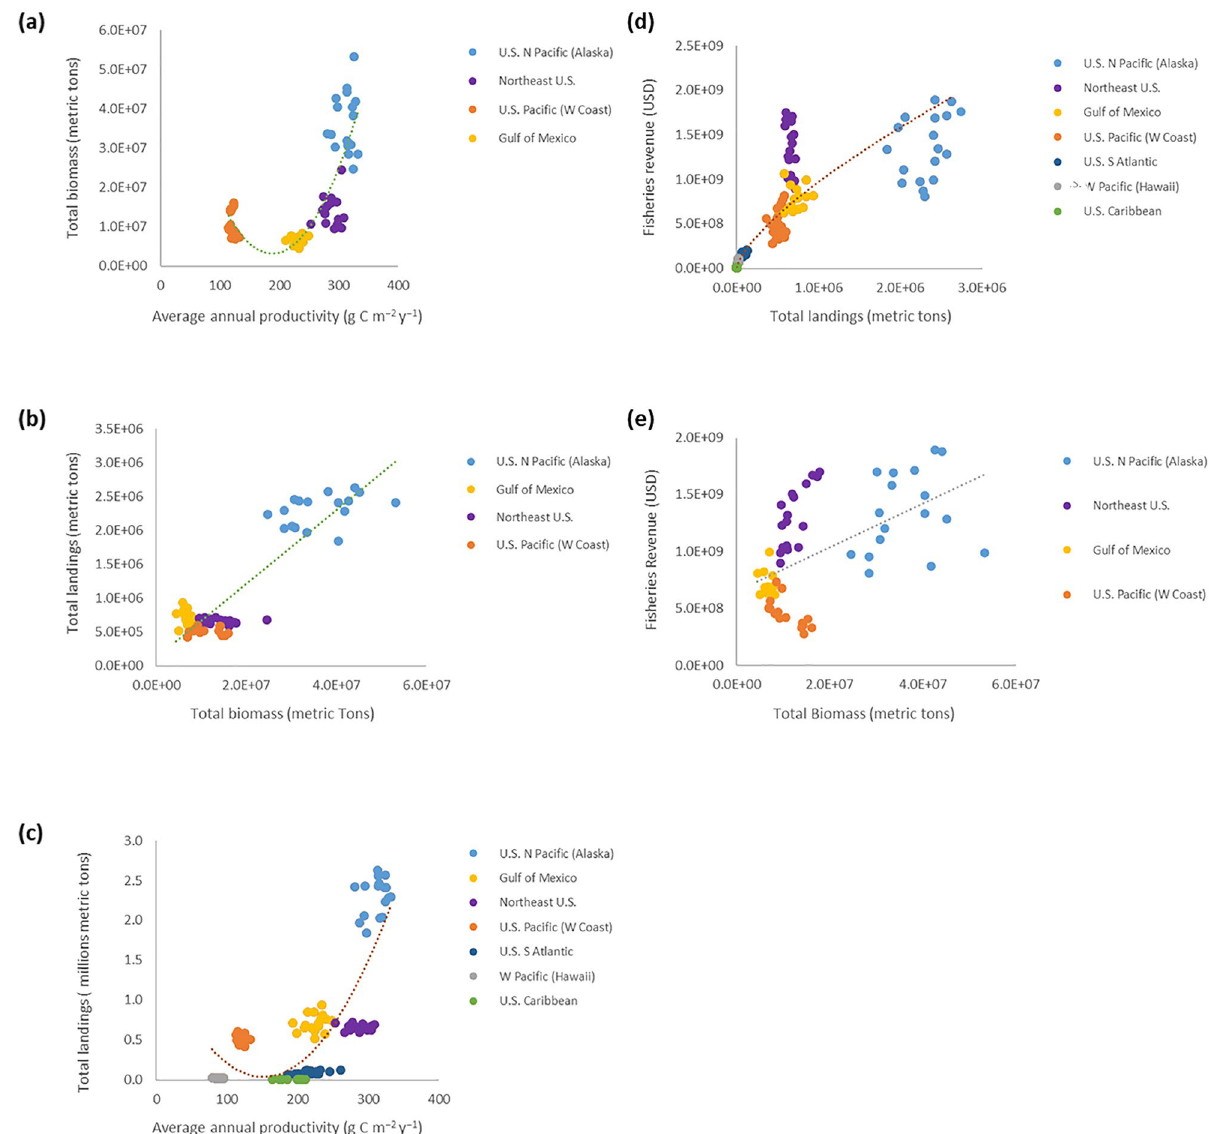
r 2 = 0.642; p < 0.0001). ( b ) Relationship between total surveyed fish and invertebrate biomass (metric tons) and total fisheries landings (metric tons; y = 0.0547x + 111,982; r 2 = 0.813; p < 0.0001). ( c ) Relationship between average annual primary productivity (g C m −2 year −1 ) and total fisheries landings (metric tons; y = 66.092x 2 − 20015x + 2 × 10 6 ; r 2 = 0.667; p < 0.0001). ( d ) Relationship between total fisheries landings (metric tons) and total fisheries revenue (USD; y = 32187x 2 − 8 × 10 6 x + 7 × 10 8 ; r 2 = 0.600; p < 0.0001). ( e ) Relationship between total biomass (metric tons) and total fisheries revenue (USD; y = 19.282x + 6 × 10 8 ; r 2 = 0.293; p <